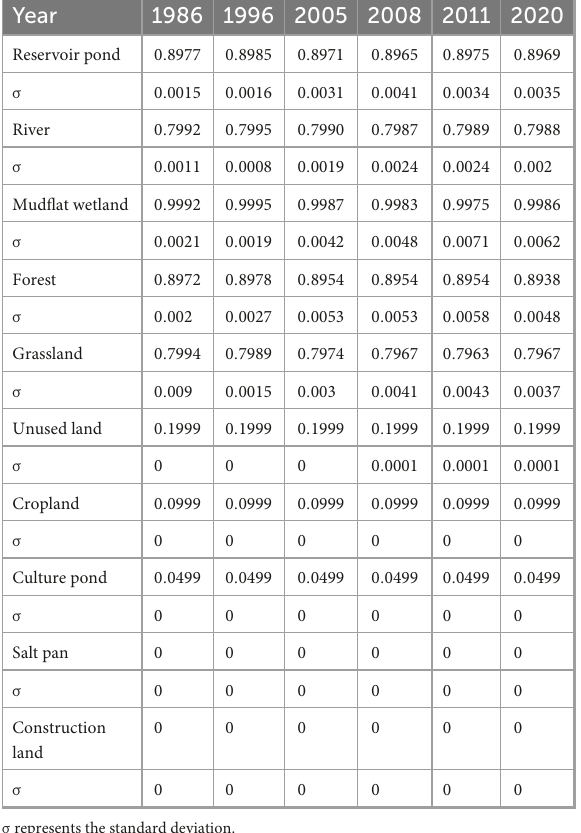
TABLE 4 Habitat quality average index of each land-use type from 1986 to